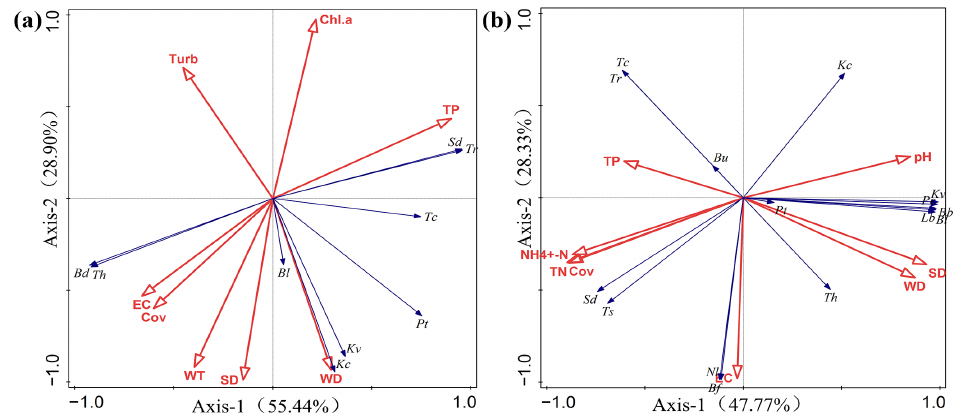
Figure 6. RDA analysis ranking of the zooplankton dominant species density and environmental factors in the period of extreme water level fluctuation ( a ) and in the period of regular water level fluctuation ( b ). Tc: Trichocerca capucina ; Tr: Trichocerca rousseleti ; Kc: Keratella cochlearis ; Kv: Keratella